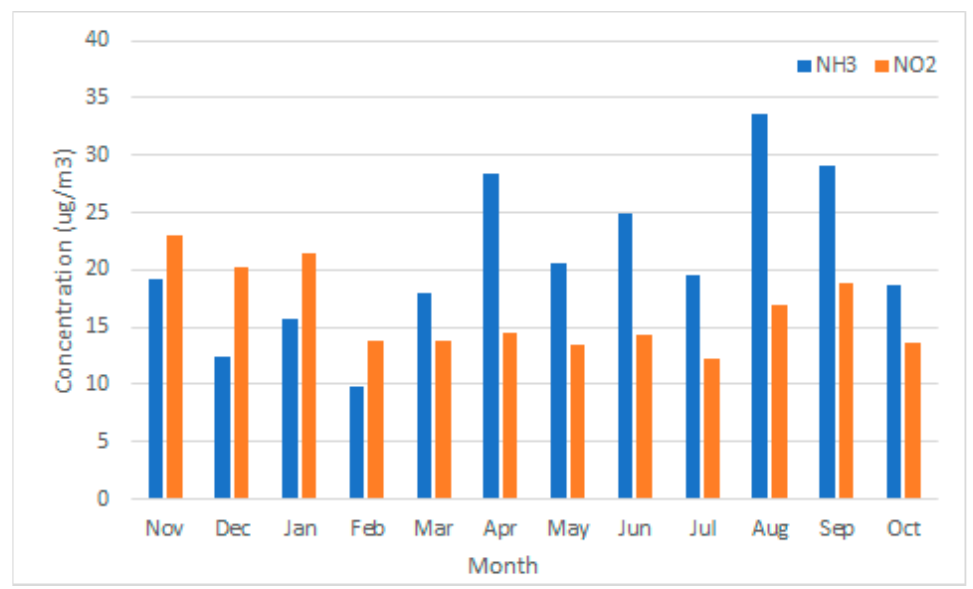
Figure 7. Maps with yearly average concentrations of ( a ) NO 2 in µg/m 3 and ( b ) NH 3 in µg/m 3 . ©OpenStreetMap contributors.